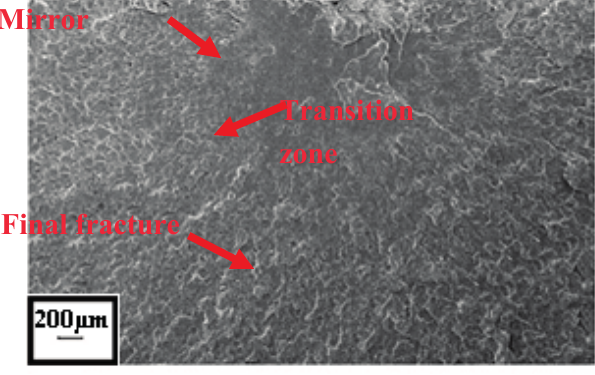
Figure 2. SEM micrograph of different zones in fracture surface of PMMA.